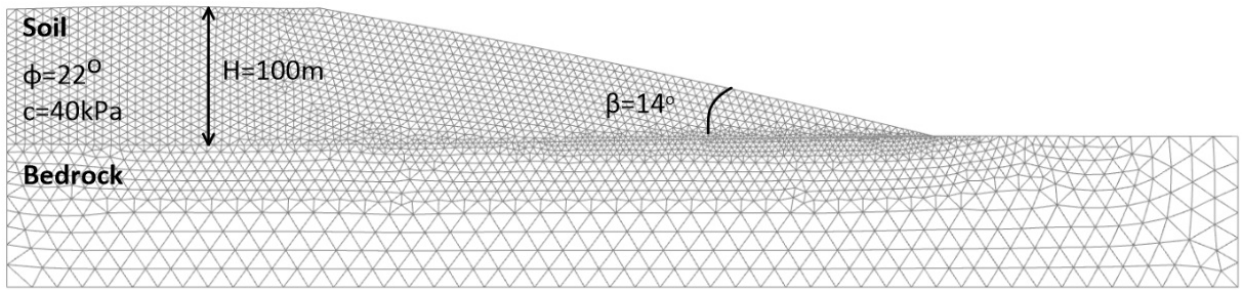
Figure 1. Finite element discretization and the main characteristics of open-pit slope.